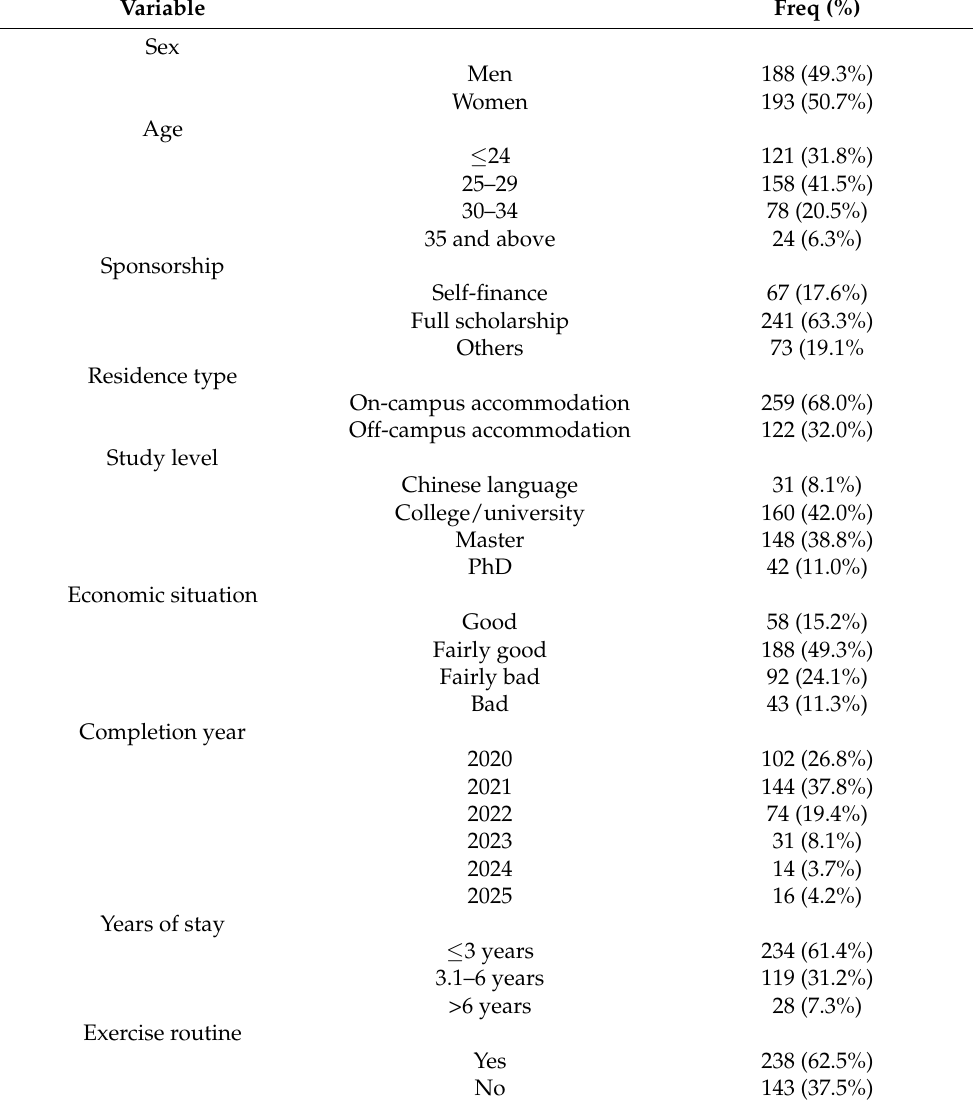
Table 1. Descriptive analysis of students’ demographic and lifestyle